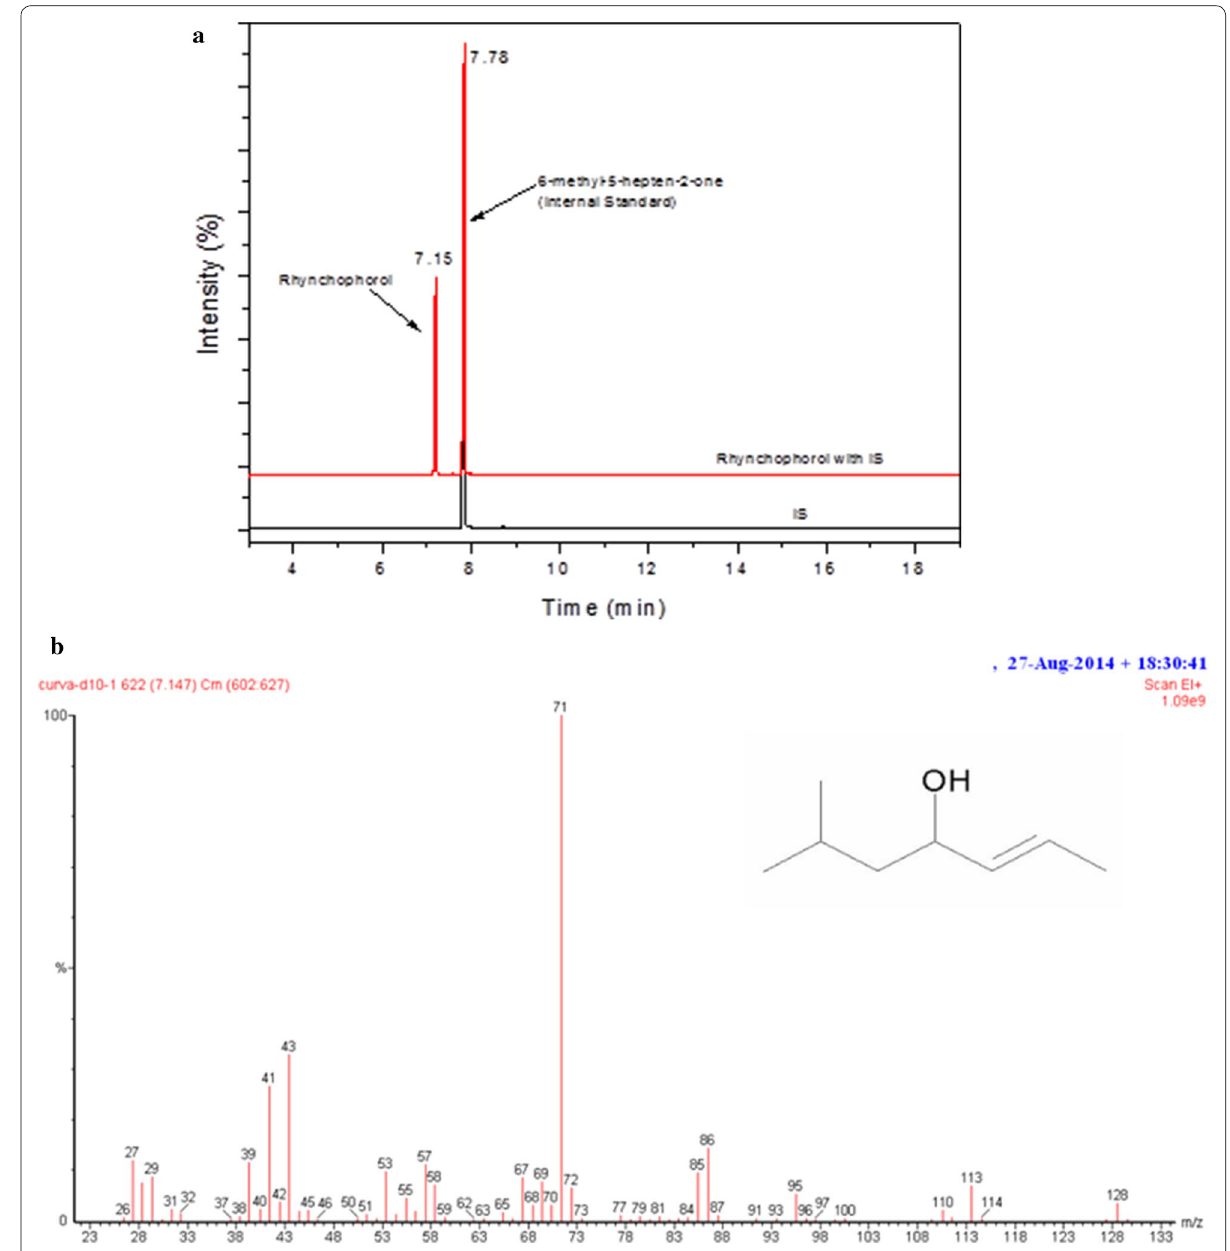
Fig. 1 Chromatograms obtained under the analytical conditions of the method: a hexane solution containing rhynchophorol and IS; b mass spec- trum obtained for